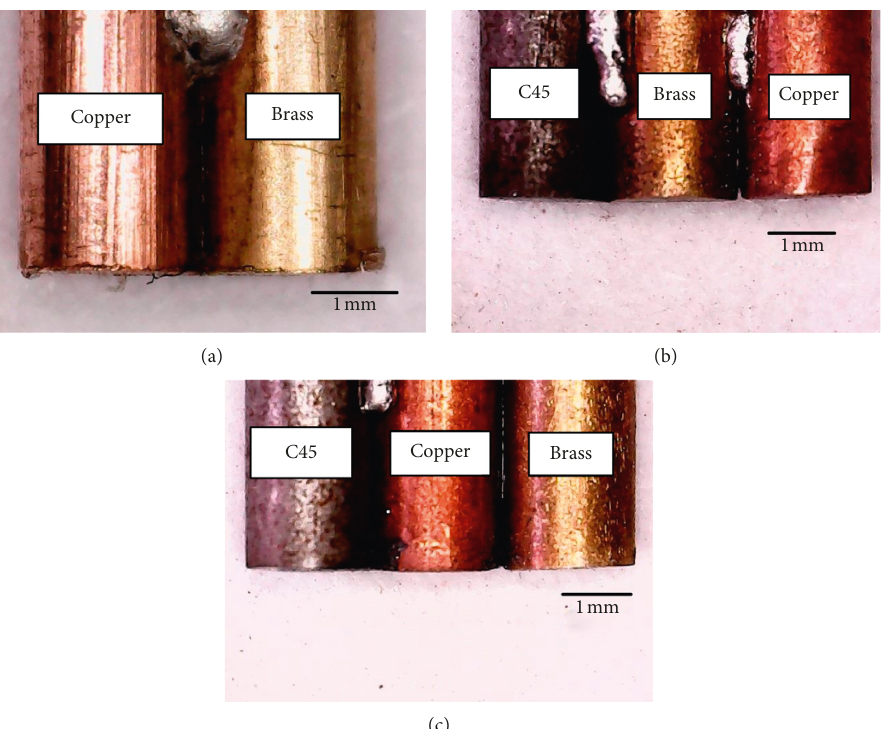
Figure 8: Different composite multimaterial electrodes before processing. (a) Copper-brass multimaterial electrode. (b) C45-brass-copper multimaterial electrode. (c) C45-copper-brass multimaterial